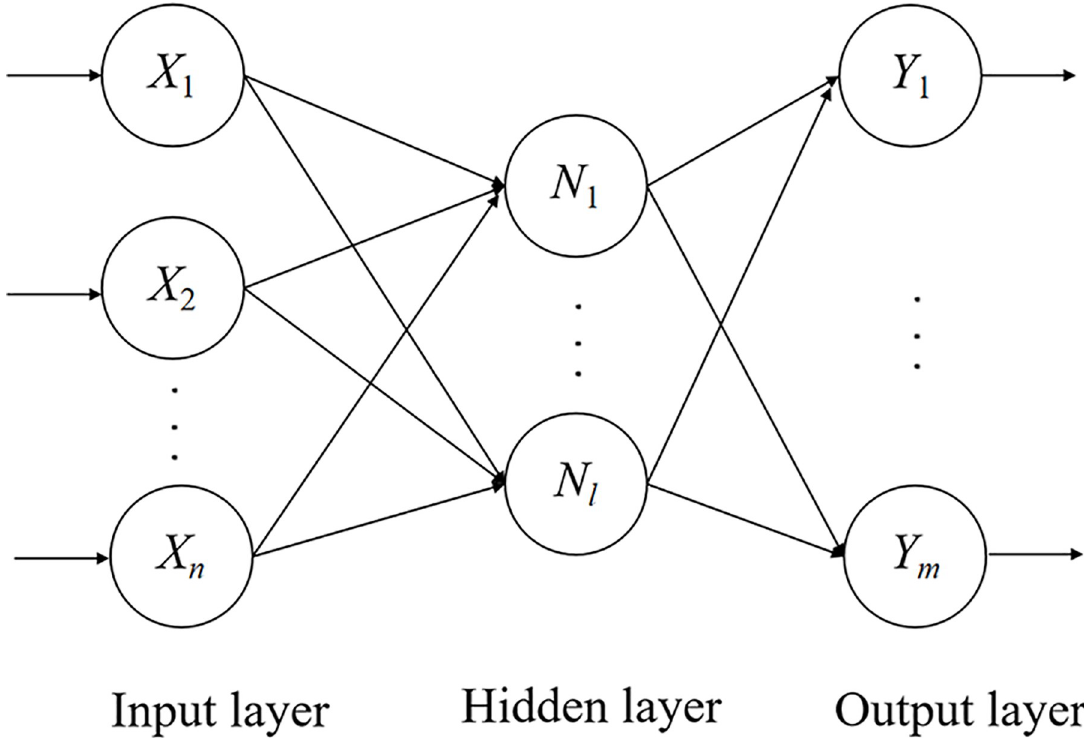
Fig 2. Schematic diagram of BP neural network